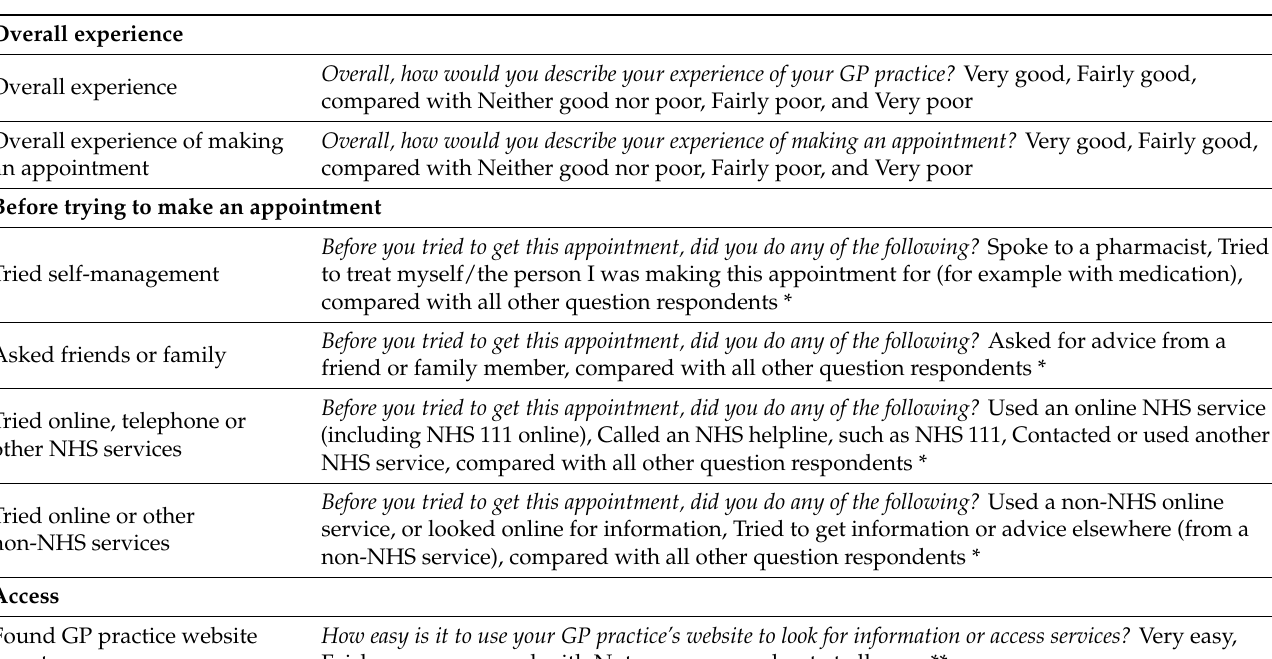
Table 1. Patient experience, question